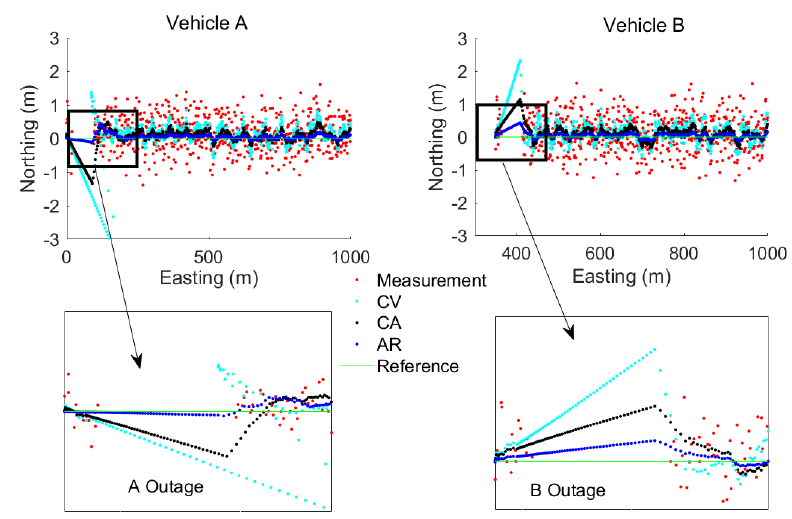
Figure 6. An example of fusion model estimated results for TC3 with rear-end collision type.